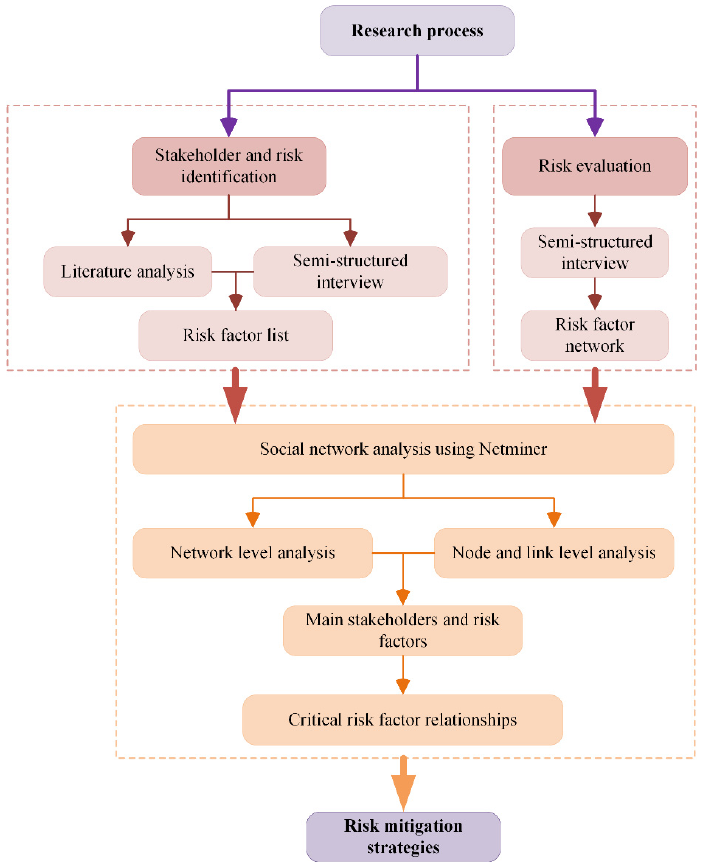
Figure 1. The research process.